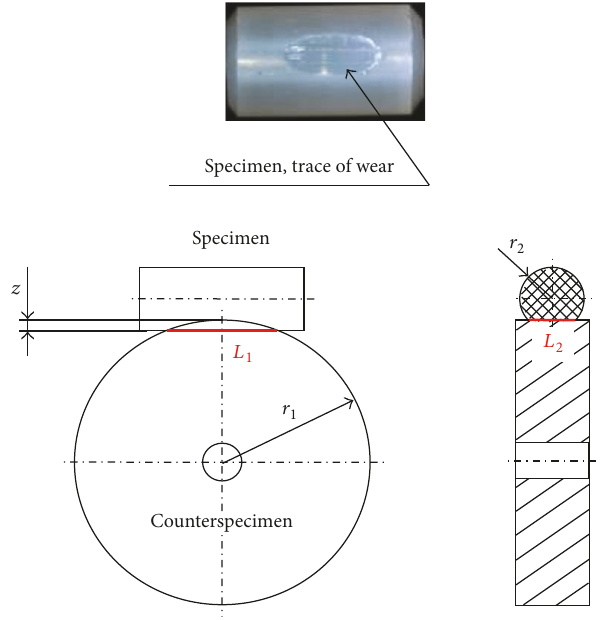
Figure 2: Specimen with trace of wear and axes of the ellipse being projection of the trace on the plane perpendicular to vertical axis of the counterspecimen: 𝑧 , linear wear of the specimen; axis 𝐿 1 , projected length of trace of wear; axis 𝐿 2 , width of trace of